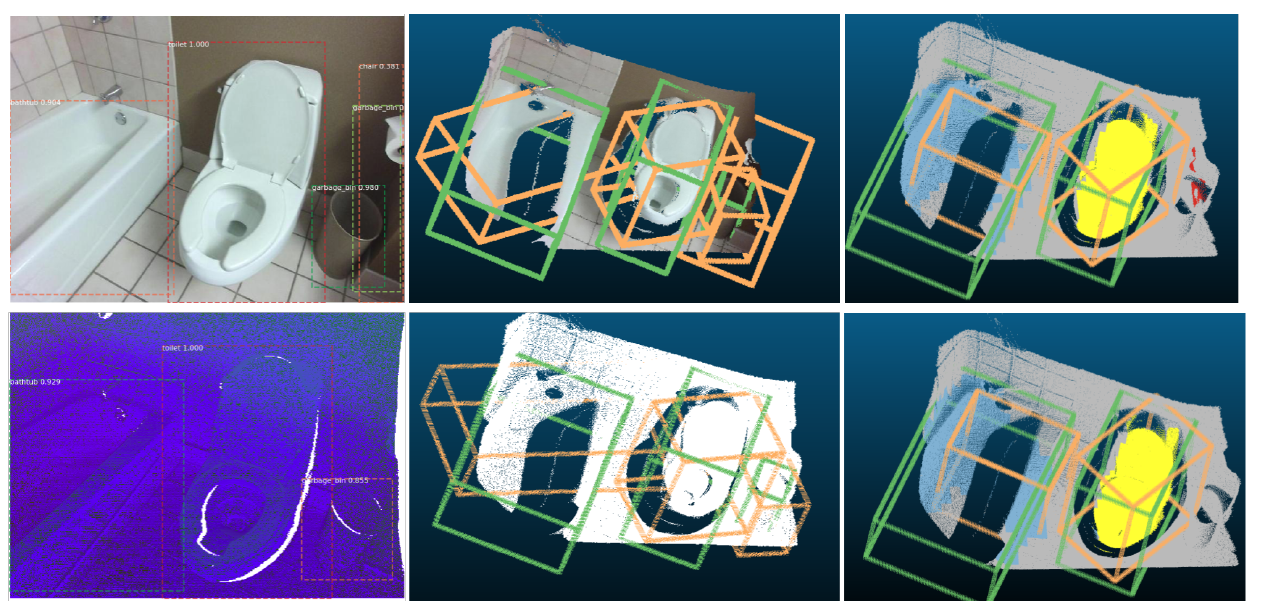
Figure 19. Visualizations of 3D detection results: In the upper one, the frustum is generated through the color image. In the bottom one, the frustum is generated based on DHS image. The middle is the 3D detection results from the Frustum VoxNet V1 and the right one is the results from Frustum VoxNet